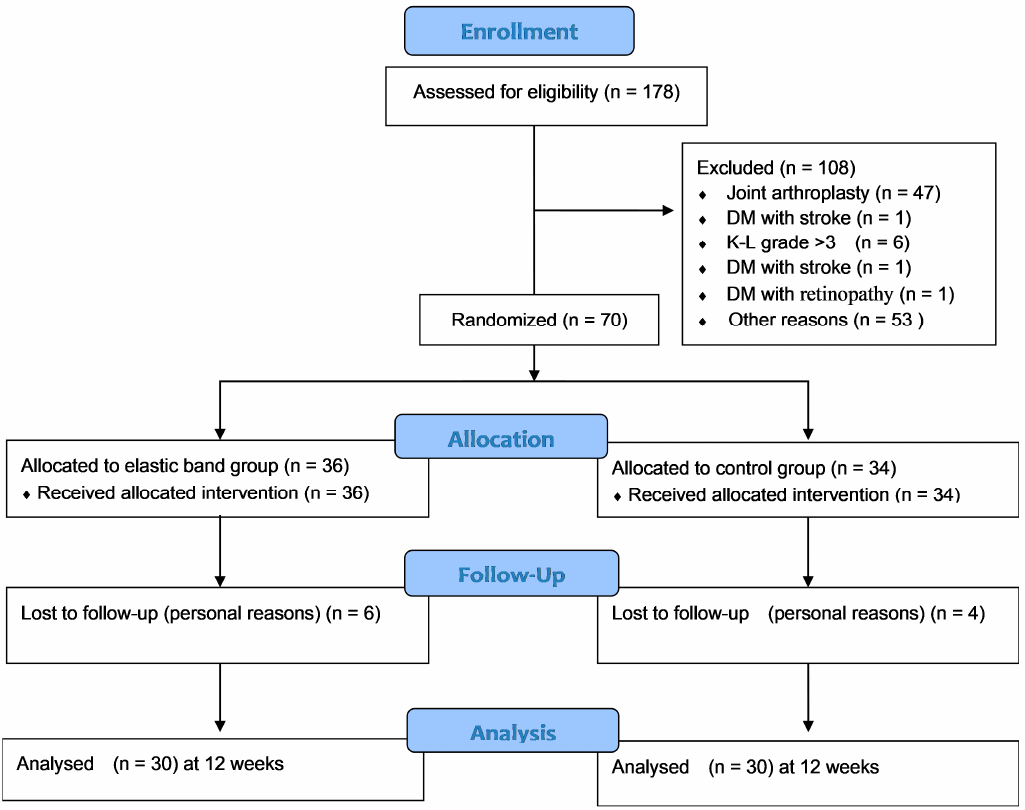
Figure 2. CONSORT flow diagram.